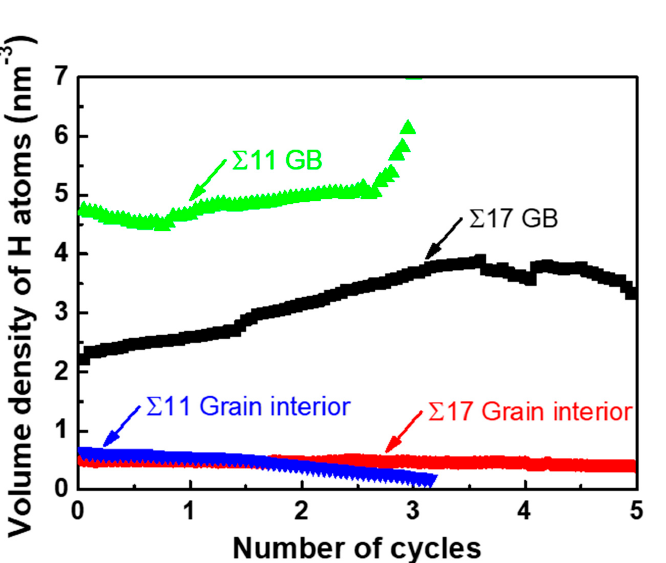
Figure 7. The volume density of segregated H atoms into the GB and the grain interior region ver- sus the number of cycles.